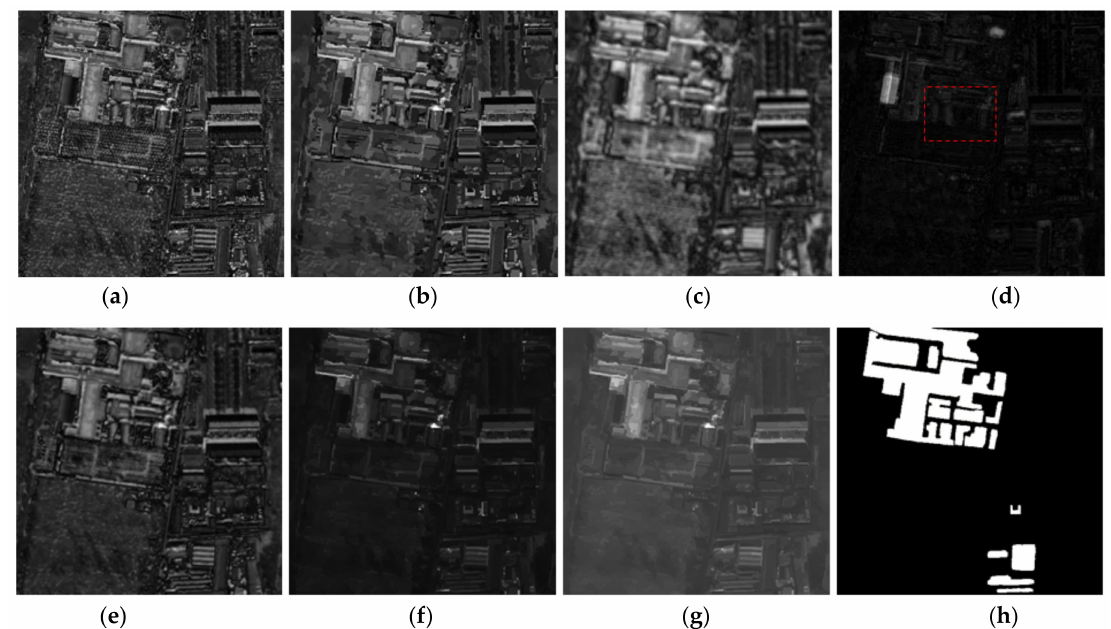
Figure 8. DIs of the first patch example of B&T data set generated by different methods: ( a ) CVA;